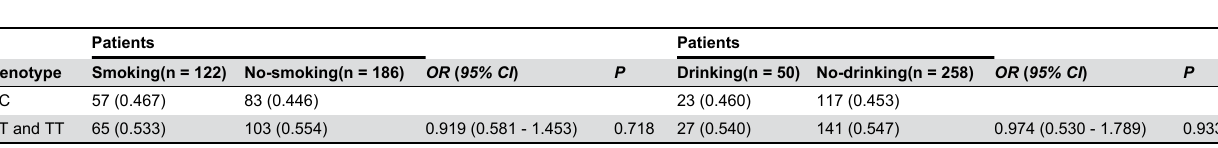
Table 4. Interaction between 781C/T polymorphism of IL-8 and smoking or drinking in